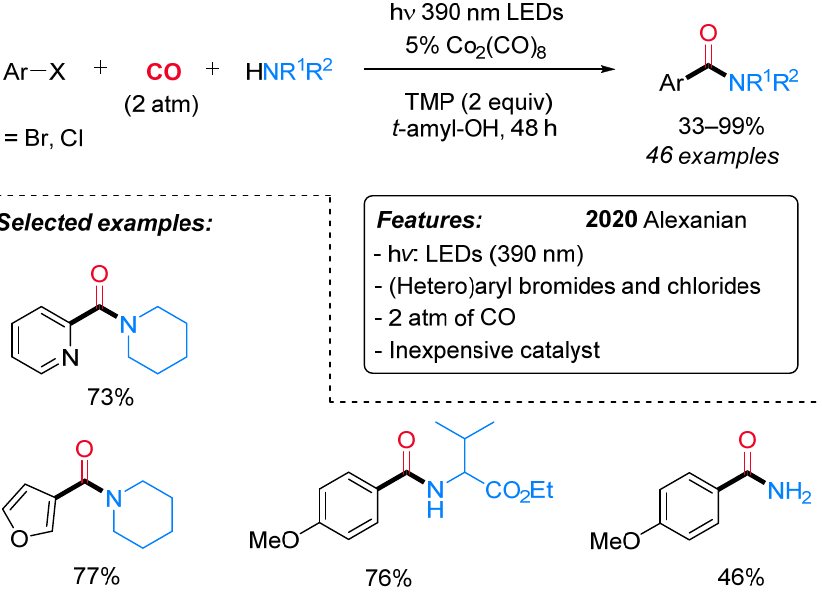
(hetero) aryl/vinyl bromides and chlorides using an inexpensive cobalt catalyst (Co 2 (CO) 8 ) in conjunction with tetramethylpiperidine (TMP) (Scheme 31)